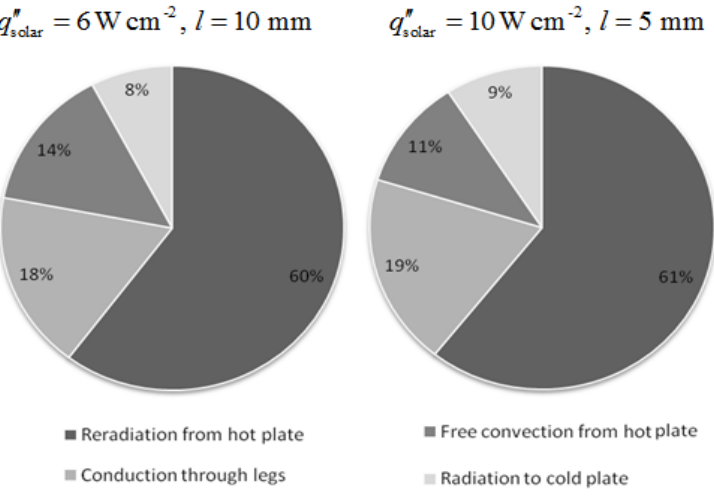
transferred by the heat transfer modes. solar